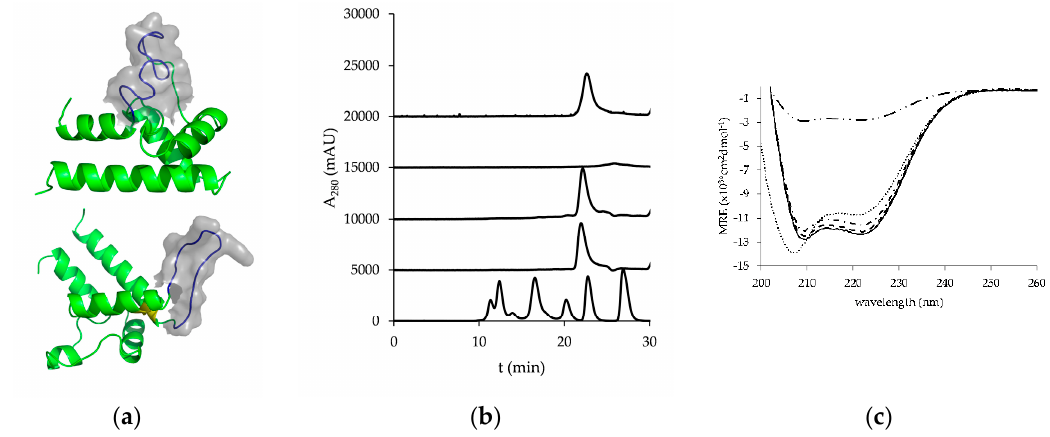
Figure 5. hCD81 LEL derivatized with anti-hTfr peptide: ( a ) Cartoon models of hCD81 LEL engrafted with anti-hTfr peptide (blue) in the D-segment (upper) or in the loop connecting helices A and B (lower). De novo introduced cysteine residues in hCD81 LEL_Tfr2_C4 are in yellow. Amino acid residues of the grafted peptide surfaced. Models were prepared with SWISS-MODEL server and figures with PyMOL (PyMOL Molecular Graphics System, Version 1.3 Schrödinger, LLC). ( b ) HPLC-SEC profiles of anti-hTfr peptide-engrafted versions of hCD81 LEL, from bottom to top: molecular weight standards at 670, 158, 44, 17 and 1.3 kDa (Bio-Rad), wild-type hCD81 LEL, hCD81 LEL_Tfr1, hCD81 LEL_Tfr2 and hCD81 LEL_Tfr2_C4. ( c ) Far-UV CD of wild-type hCD81 LEL (dashed line), hCD81 LEL C4 (full line), hCD81 LEL_Tfr1 (dotted line), hCD81 LEL_Tfr2 (dash-2 dots line), and hCD81 LEL_Tfr2_C4 (dash-dotted line). hTfr: human transferrin receptor.